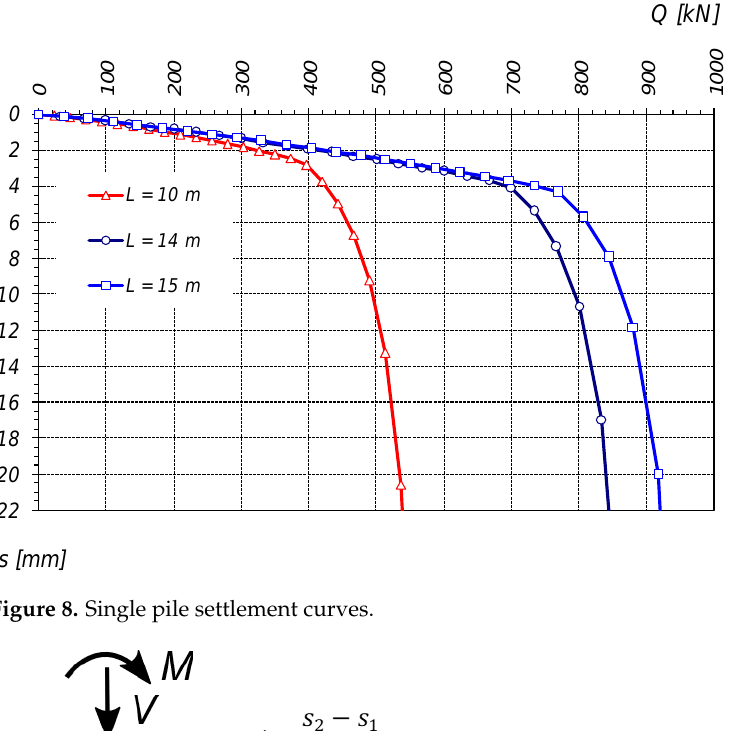
Figure 8. Single pile settlement curves.